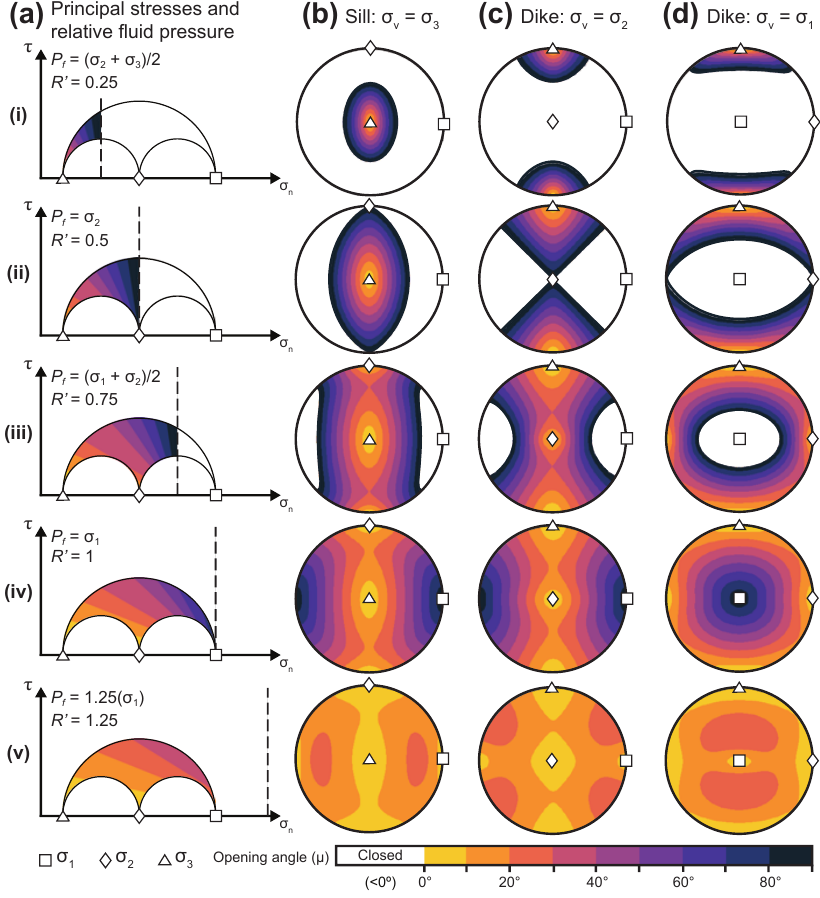
Figure 3. Mechanical models showing contoured fracture-opening angles for various stress and fluid pressure conditions, using the equation from Delaney et al. (1986), projected onto lower-hemisphere, equal-area stereonets and Mohr circles (colour scheme from Thyng et al., 2016). The dashed line on the Mohr circles indicates the fluid pressure magnitude. Five increments of fluid pressure (a i–v ) have been modelled with three stress states: (b) thrust-fault regime ( σ v = σ 3 ), (c) strike-slip regime ( σ v = σ 2 ), and (d) normal-fault regime ( σ v = σ 1 ). Colour contours correspond to pole-to-plane values. Poles that plot in the yellow zone (where µ = 0–10 ◦ ) will display approximately plane-normal opening; poles with larger opening angles will display extensional-shear dilation and have a smaller true thickness than adjoining segments that plot in the yellow